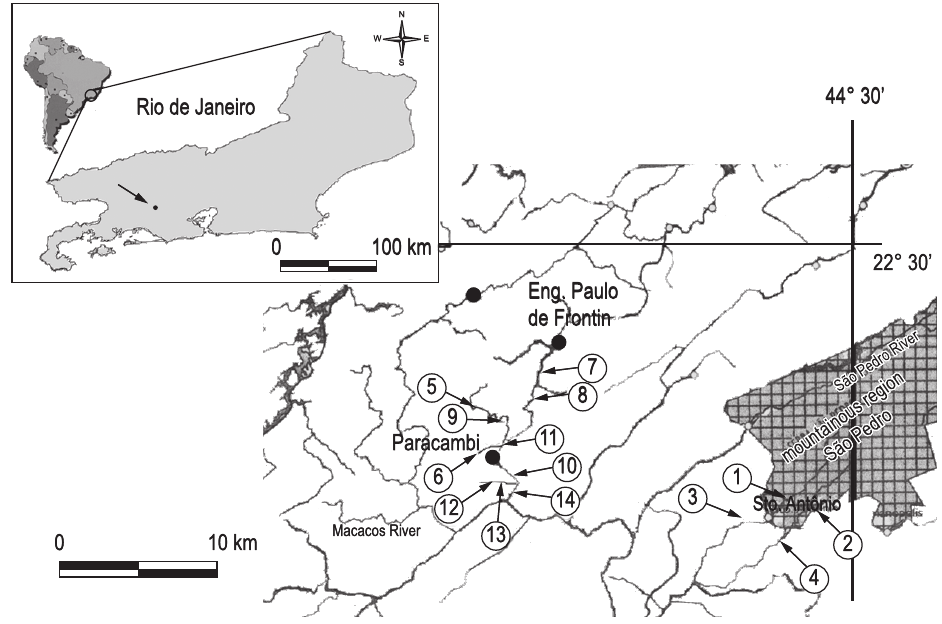
Figure 1. Location of sampling sites: S1 and S2 Reference, S3 and S4 Low impaired, S5 and S6 Deforested, S7, S8, S9, S10, S11, S12, S13 and S14 Impaired. Above the arrow indicate the study area in the Rio de Janeiro State. Below the checkered gray area indicate the Permanent Preservation Area of the Biological Reserve of Tinguá, Rio de Janeiro State,